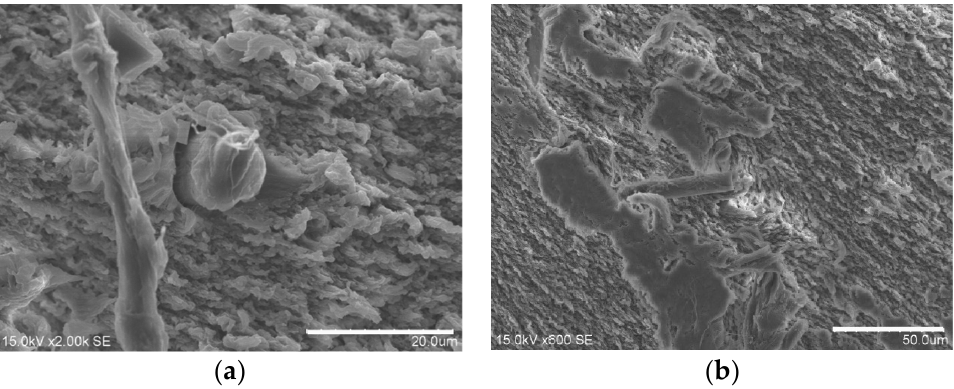
Figure 11. SEM image of the 1% 7 µ m CF-filled PTFE tensile section: ( a ) the magnification 2000 × ; ( b ) the magnification 600 × .